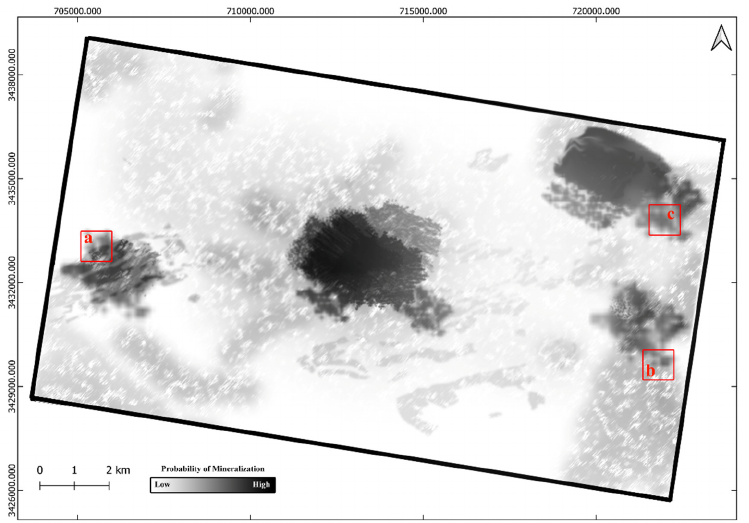
Figure 7. Potential map of the study area generated from Fuzzy-AHP model. (+80% is acceptable). The inserted cubs (a, b and c) are field checkpoints.